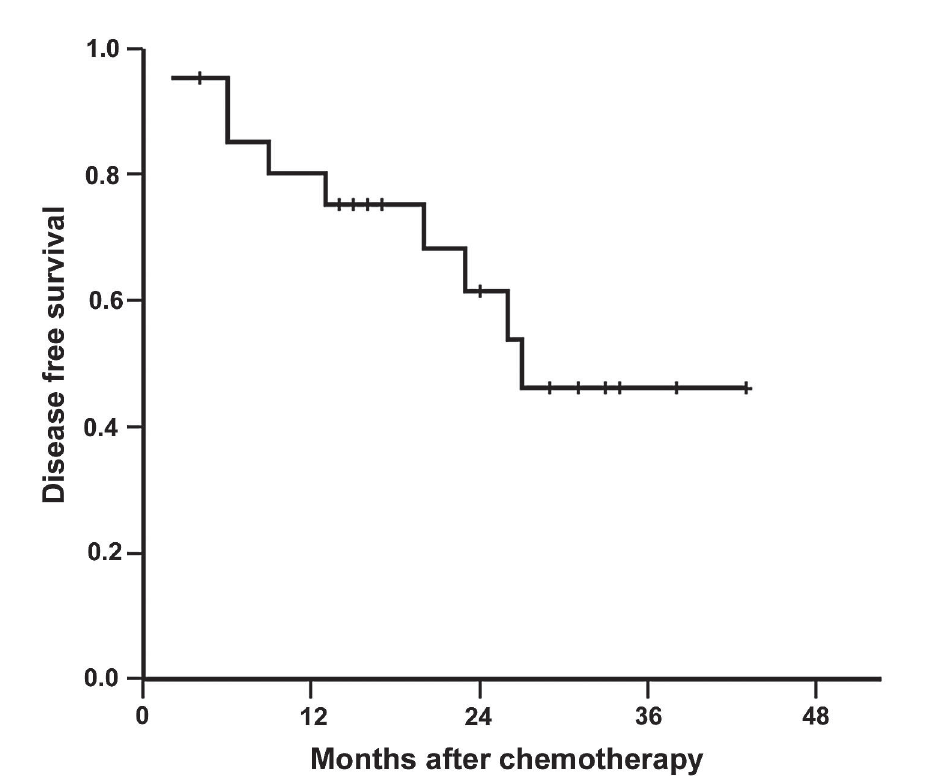
Figure 1 – Progression-free survival of 21 patients treated with neoadjuvant gemcitabine and cisplatin for invasive bladder